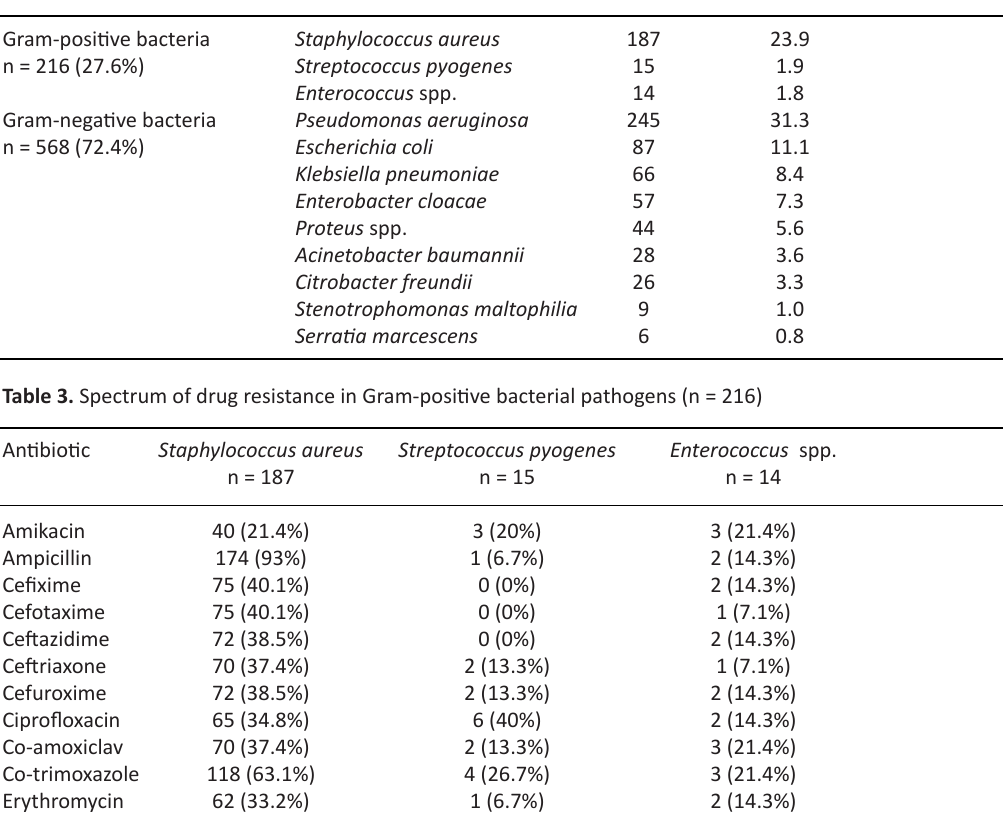
Table 2. Distribution of pathogens recovered from pediatric wound infections (n = 784) Bacterial pathogens